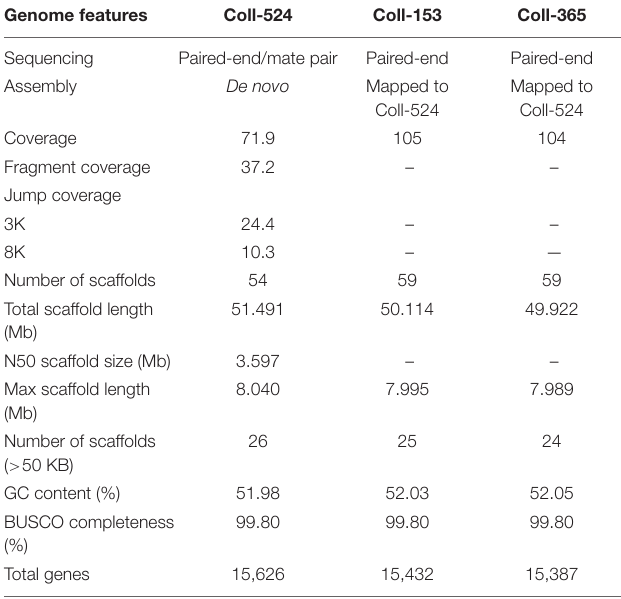
TABLE 2 | Genome features of Colletotrichum scovillei strains Coll-524, Coll-153, and